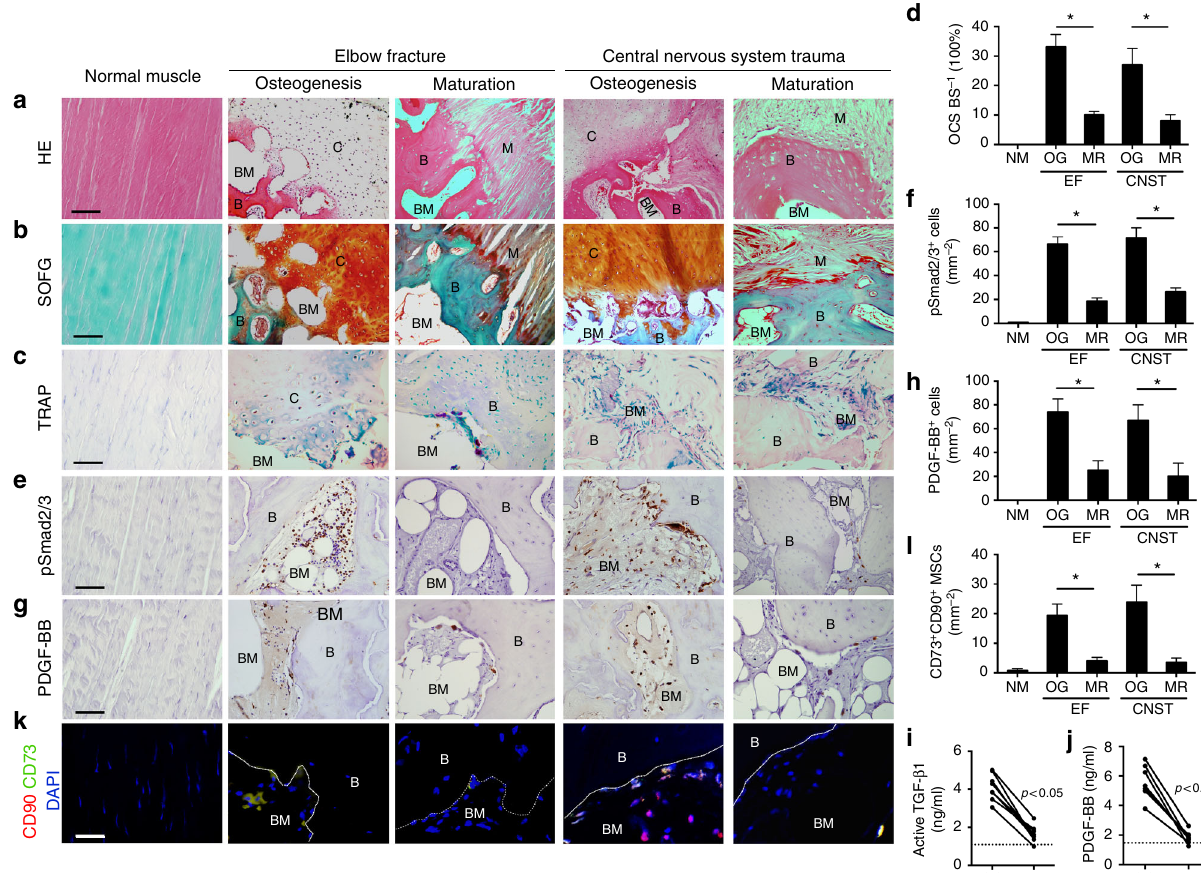
Fig. 1 Elevated active TGF- β levels in human HO. a H&E staining of normal muscle (left) and HO in early osteogenesis stage (middle) and late osteogenesis stage (right) after elbow fracture (EF) and central nervous system trauma (CNST). Scale bar, 100 μ m. b Safranin O and Fast Green (SOFG) staining of normal muscle (left) and HO. Proteoglycan (red) and heterotopic bone (green). Scale bar, 100 μ m. c TRAP + cells (red) and d quantitative analysis of the number of TRAP + osteoclast surface (OCS) per bone surface (BS). Scale bar, 100 μ m. Immunohistochemical staining of e pSmad2/3 + cells (brown) and g PDGF-BB + cells (brown) and quantitative analysis of the number of f pSmad2/3 + cells or h PDGF-BB + cells per bone marrow area (mm 2 ). i , j Quantitative analysis of i active TGF- β and j PDGF-BB in serum in HO patients at early osteogenesis stage and late mature stage by ELISA. Dotted line indicates the average concentration of healthy people with active TGF- β of 1.23 ng/ml and PDGF-BB of 1.68 ng/ml. k Immuno fl uorescent staining and l quantitative analysis of CD73 + (green) and CD90 + cells (red) in bone marrow of ectopic bone marrow in HO patients. Blue color indicates DAPI staining of nuclei. Scale bar, 20 μ m. C cartilage, B bone, BM bone marrow, M muscle, NM normal muscle, EF elbow fracture, CNST central nervous system trauma, OR osteogenesis MR maturation. All data are shown as the mean ± s.d. n = 9 per group for d , f , h , l histomorphometry analysis. * p < 0.05 as determined by unpaired, two-tailed Student ’ s t- test. n = 8 per group for i , j ELISA analysis. * p < 0.05 as determined by paired, two-tailed Student ’ s t-